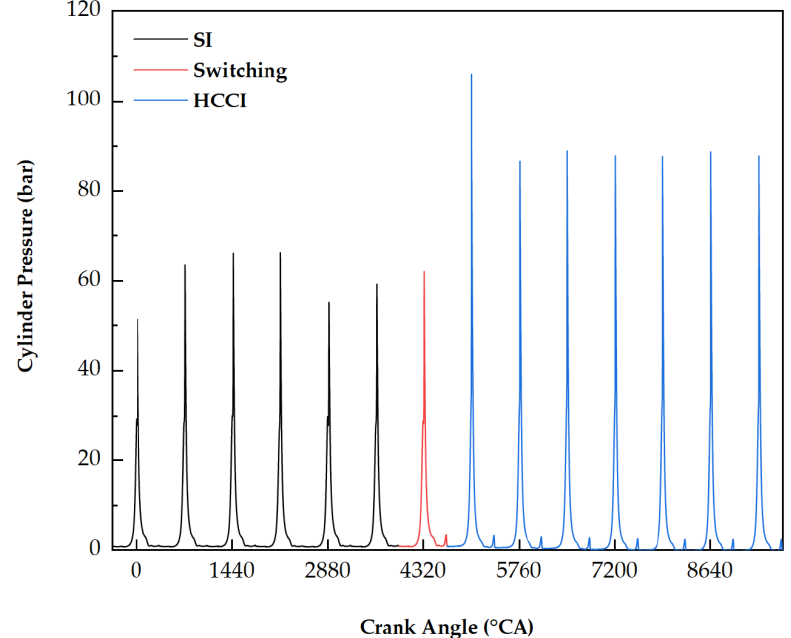
Figure 11. Cylinder pressure curve change during switching.